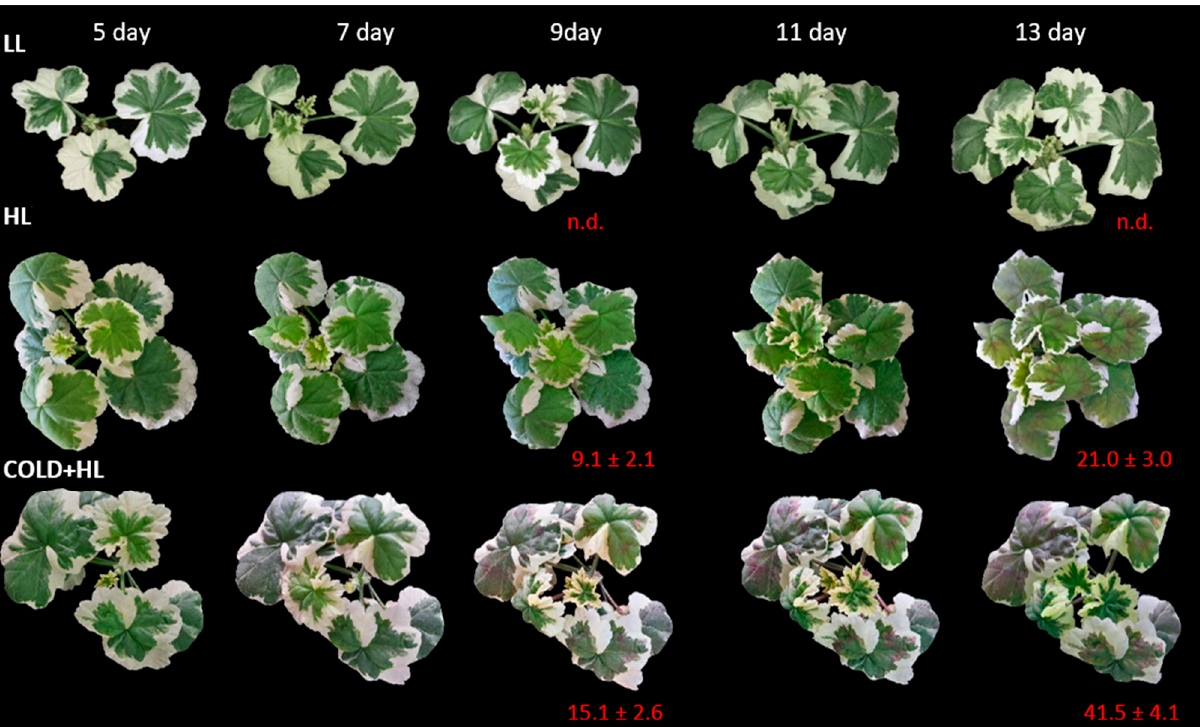
Figure 7. Representative P. zonale plants and cyanidin (Cy) concentrations (nmol g –1 FW ± SE, n = 5–9) after acid hydrolysis in GL during the HL and Cold + HL experiments.